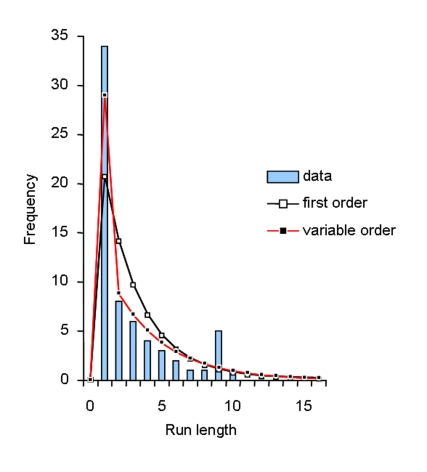
Distribution of the run length of emerged roots.The observed distribution (i.e. number of successive emerged roots) is extracted from the data while the theoretical distributions are computed from an estimated first-order or variable-order Markov chain.